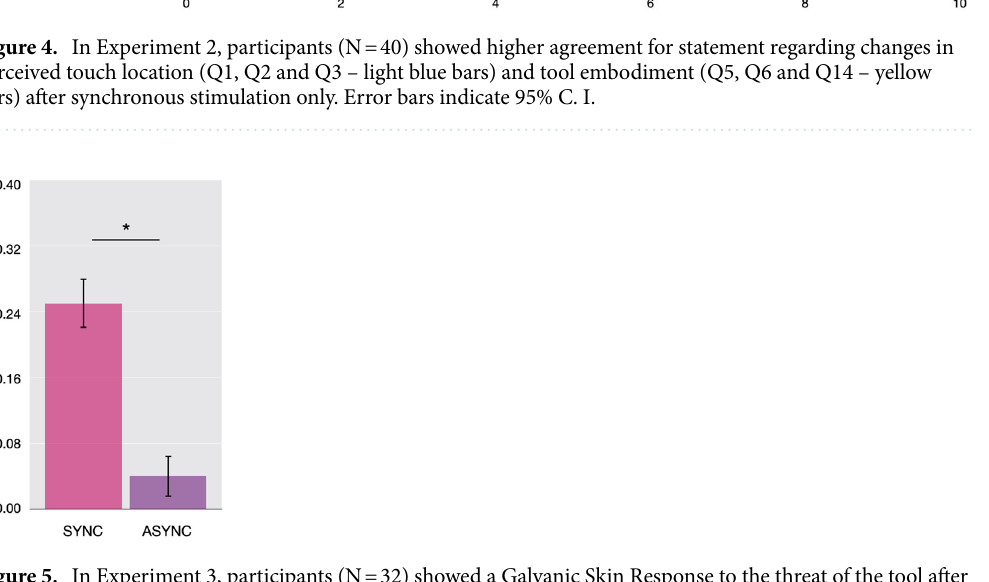
Figure 5. In Experiment 3, participants (N = 32) showed a Galvanic Skin Response to the threat of the tool after it was brushed synchronously, but not asynchronously, with their own index finger. Error bars indicate 95%